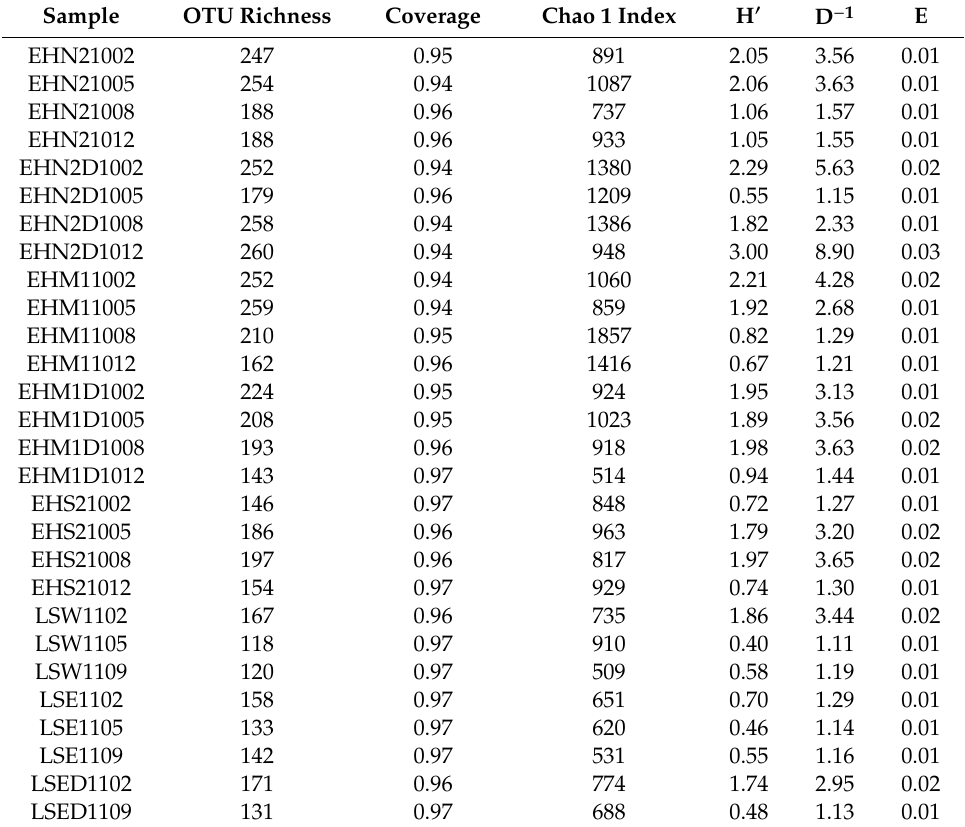
Table 1. Cyanobacterial diversity indices based on OTUs of cpcBA -IGS. H (cid:48) = Shannon index, D − 1 = Inverse of Simpson index (D), E = Simpson’s evenness